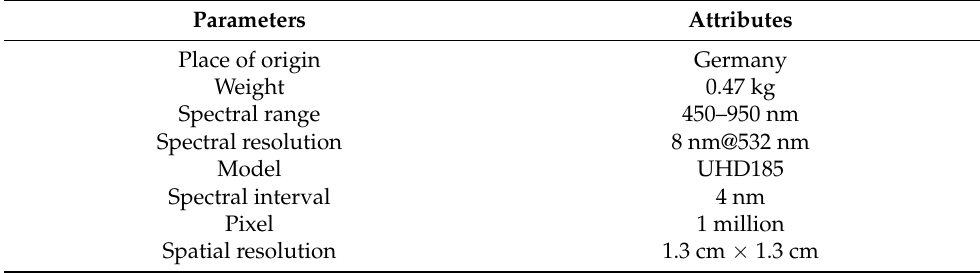
Table 1. Major specifications of Cubert UHD185 firefly imaging spectrometer.